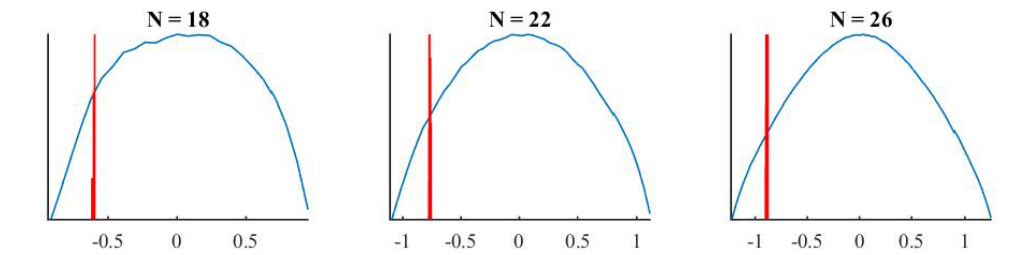
Figure 19 . Density of states of the SYK model (blue), and the energy eigenstates excited in the equilibrium state j (cid:9) 0 i (red).